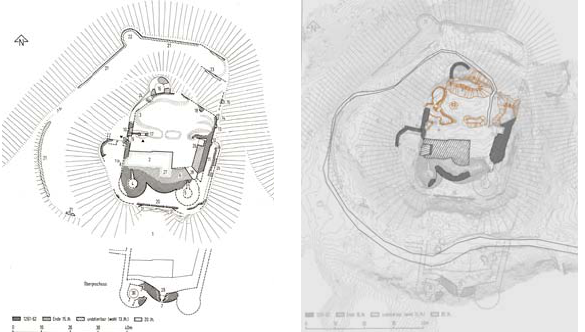
Figure 1 : Technical drawing representing the different phases of the castle as well as the remarkable elements available for the reconstruction (Biller and Metz, 1995) and superposition of the DTM and point